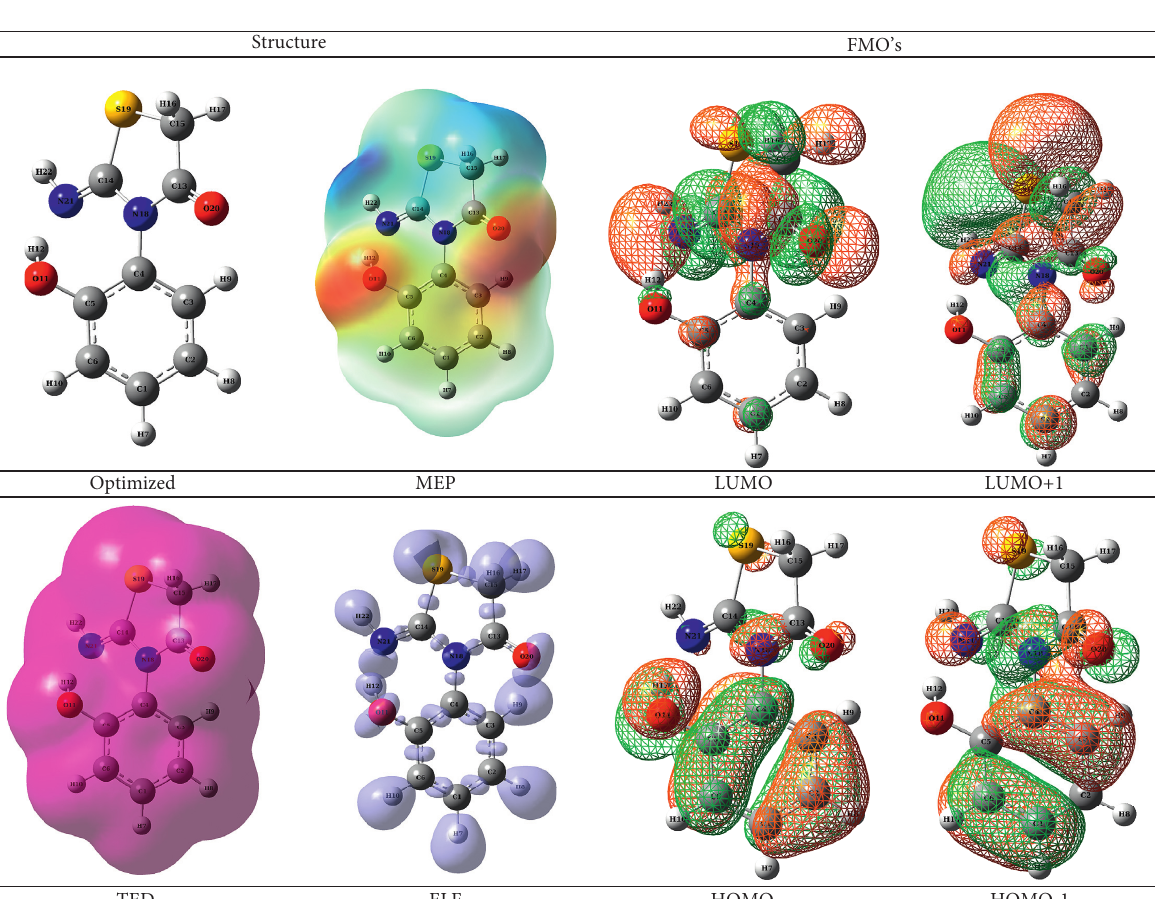
Figure 3: Optimized structure, FMOs, surfaces, and ELF plots of